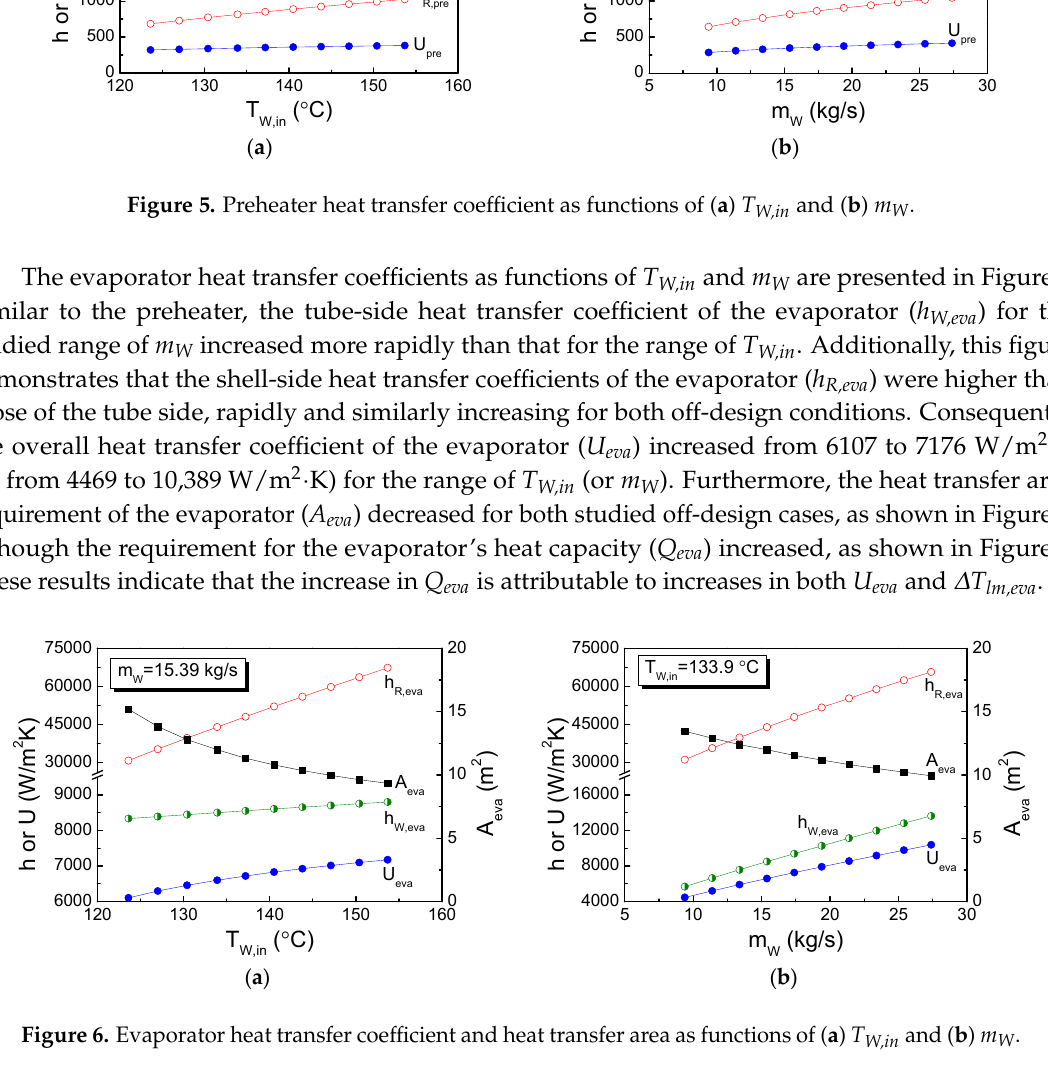
( b ) Figure 7. Net power output as functions of ( a ) T W,in and ( b ) m W . Additionally, for further comparison, Figure 7 presents results of previous studies that used the pressure control approach for off ‐ design conditions. It is clear that W net was generally higher than that of previous studies when T W,in or m W exceeded the design point. On the contrary, W net was generally lower than that of previous studies when T W,in or m W was smaller than the design point. These results indicate that the control strategy should be significantly different for various off ‐ design conditions. To obtain maximum net power output, the flow rate control approach is optimal when T W,in or m W exceeds the design point, but the pressure control approach is better when T W,in or m W is lower than the design point. In addition, it should be mentioned that the present study is a theoretical analysis and a wide variation of the power output can therefore be obtained. However, in practice, such wide variations might not be possible because the hardware cannot function well at those extreme off ‐ design conditions. The experimental results of the present turbine ORC system using the pressure control approach demonstrated that the power output ranged from about 113 to 242.5 kW